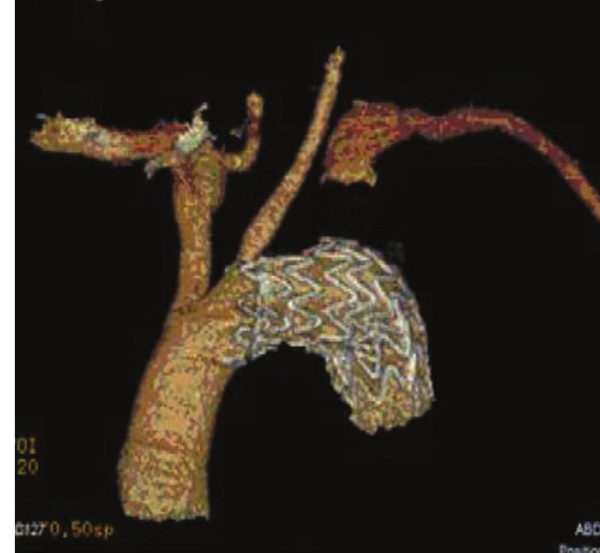
Figure 2: Intraoperative aortic arch angiography visualizing the origin of the left subclavian artery. Aortic coarctation is also demonstrated